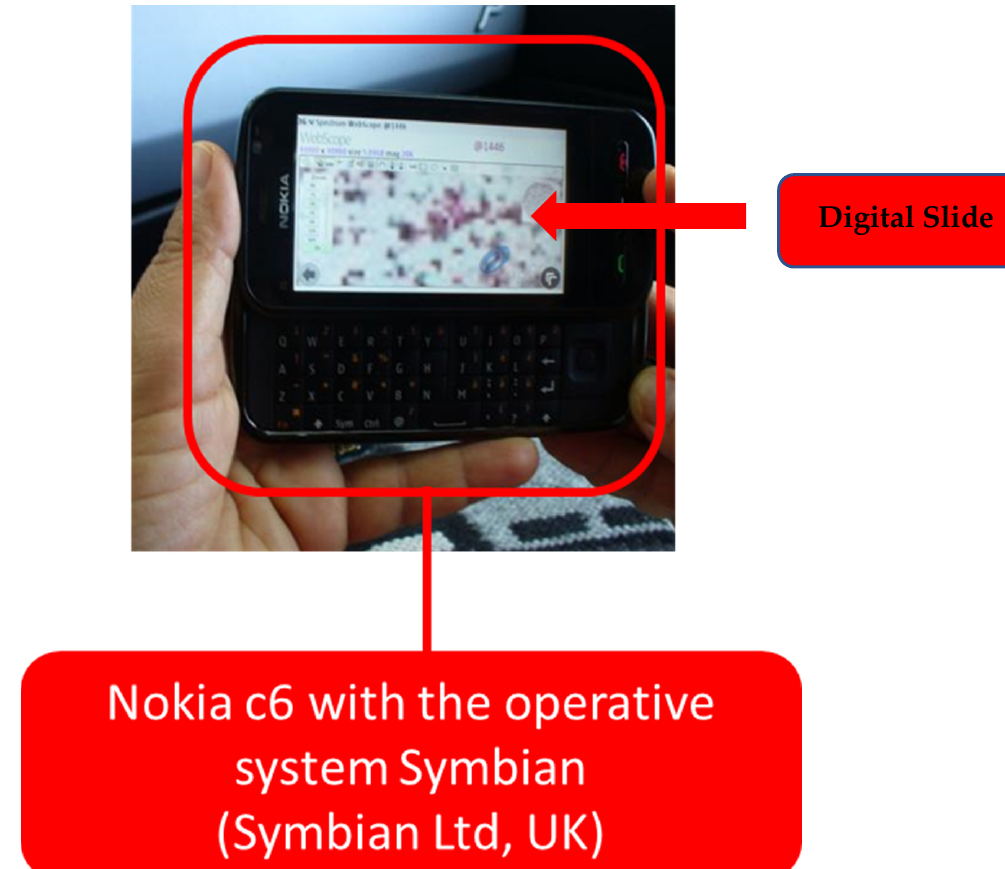
Figure 2. Access to the digital slides using mHealth not using the smartphone.